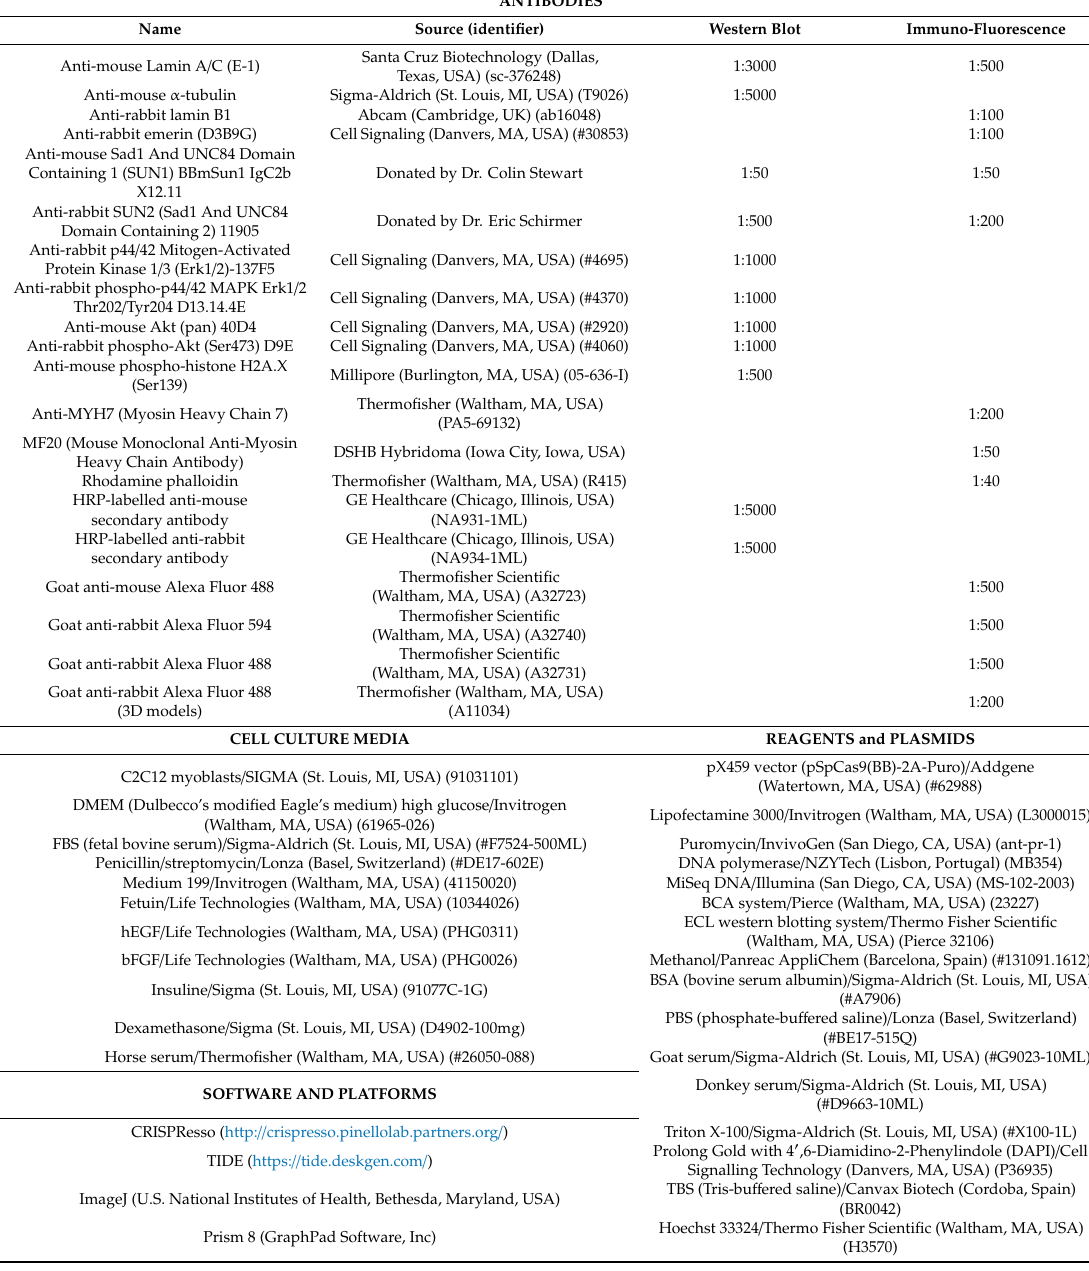
Table 1. Key resources used in this work.